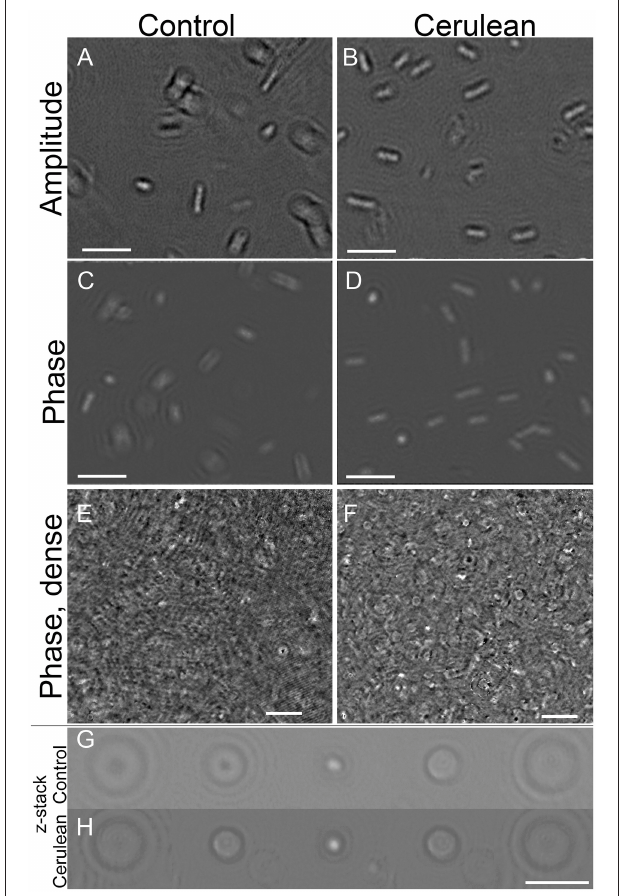
FIGURE 7 | Control cultures of E. coli (left) vs. Cerulean-expressing E. coli (right). Scale bar = 5 µ m for all panels. Phase range is –pi to pi. (A,B) Amplitude. (C,D) Phase. (E,F) Dense culture, phase. (G) Control phase, 5 consecutive z planes of a cell positioned end-on. (H) Cerulean phase, 5 consecutive z planes of a cell positioned